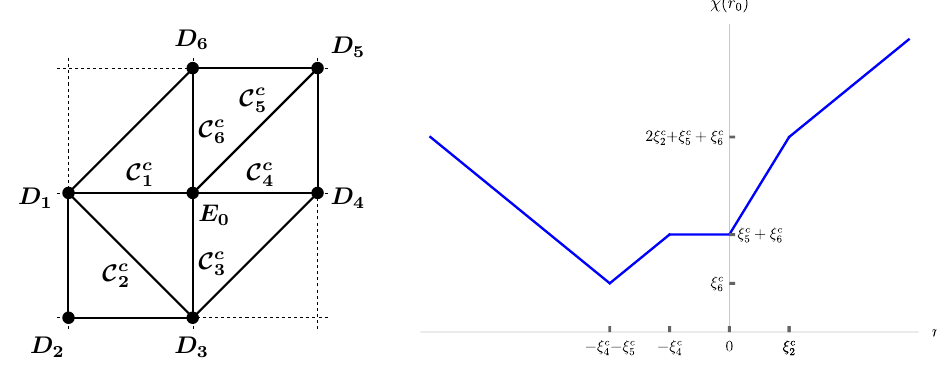
Figure 12: The first three resolutions, (a), (b) and (c), of the E ) upon vertical IIA profiles χ ( r 0